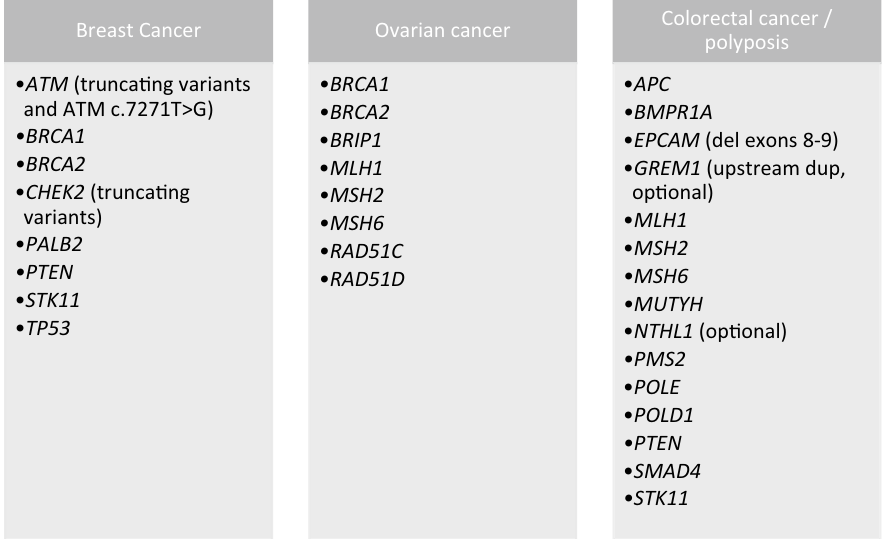
Figure 1. The UK Cancer Genetics Group consensus for genes to be included on cancer panels 1 . Figure created from Taylor et al. 1